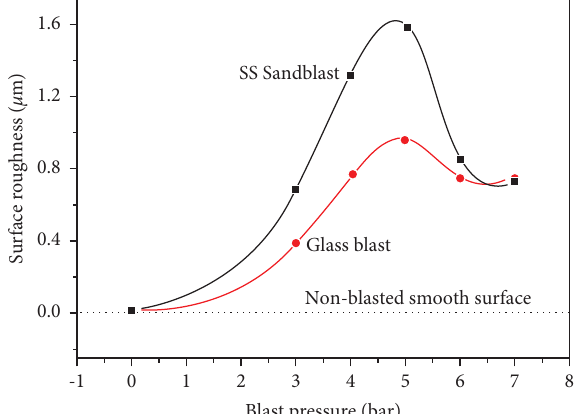
Figure 4: Surface roughness for diferent blasting